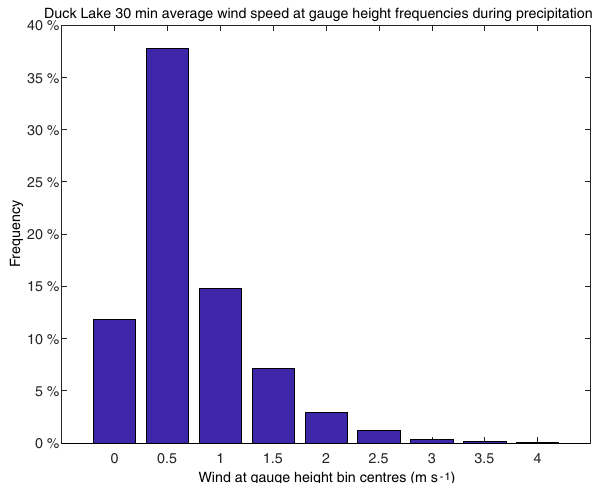
Figure 6. Thirty-minute average wind speed at gauge height fre- quency distribution during precipitation events at the Duck Lake geolysimeter site.